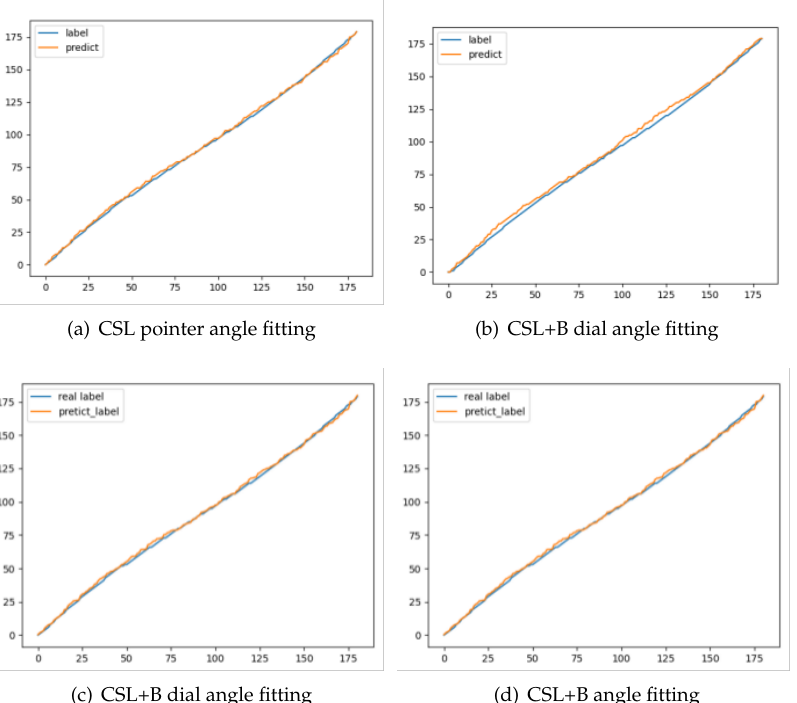
Figure 5. Annotation and prediction angle fitting curve.